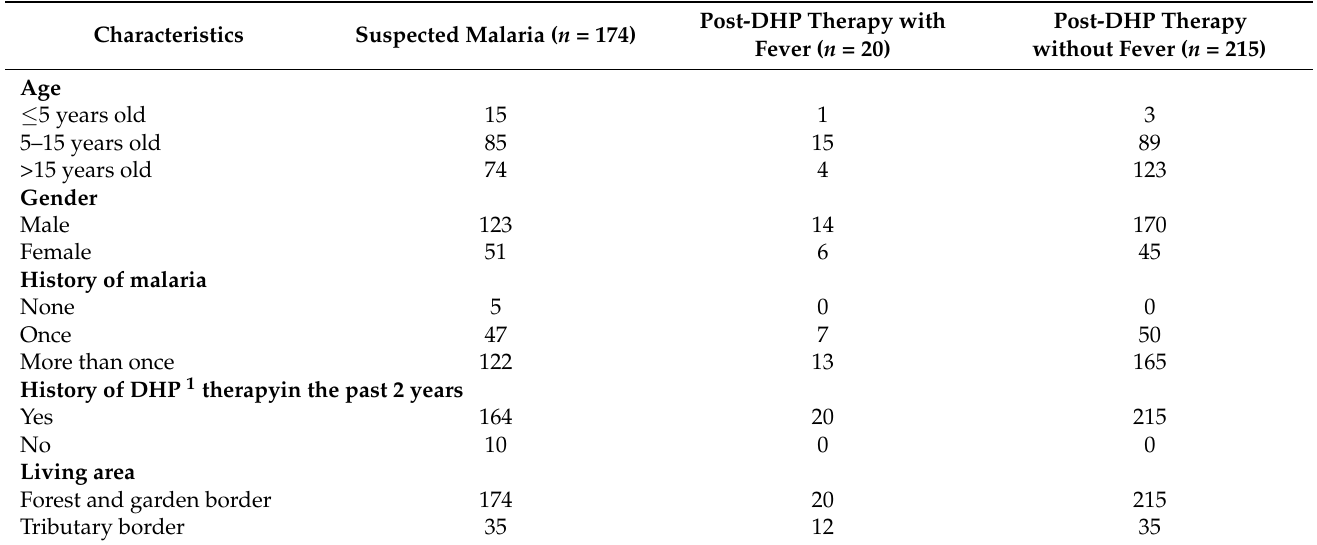
Table 1. Characteristics of participants with suspected malaria, post-DHP therapy with fever, and post-DHP therapy without